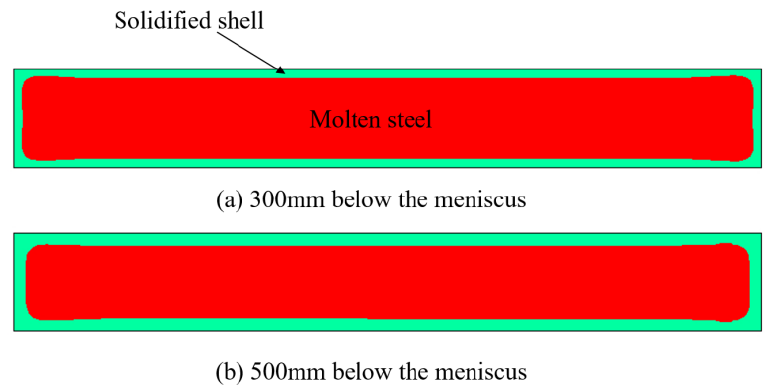
Figure 10. Solidification of the shell at different heights. ( a ) 300 mm below the meniscus, ( b ) 500 mm